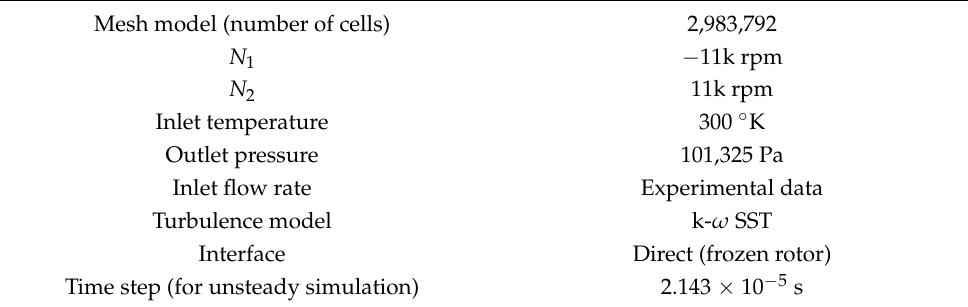
Figure 6. More details of mesh used for CFD simulation. Table 3. Boundary condition of the CFD model.